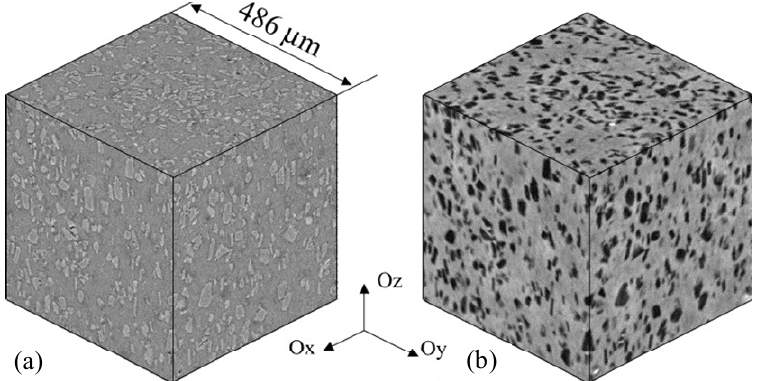
Figure 11. Reconstructed microstructure of 20 vol% Al two types of X-ray microcomputed tomography. ( a ) Phase-contrast tompography; and ( b ) holotomography [66].